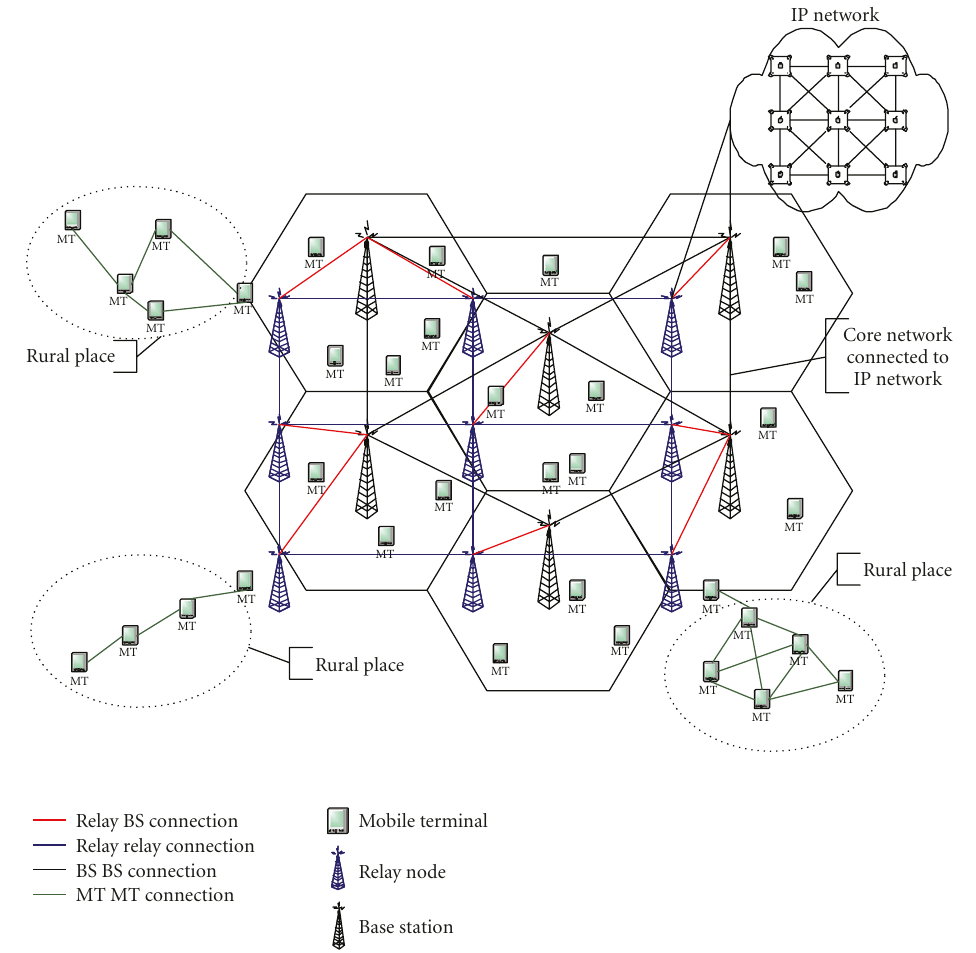
Figure 1: The hybrid wireless network with fixed relay